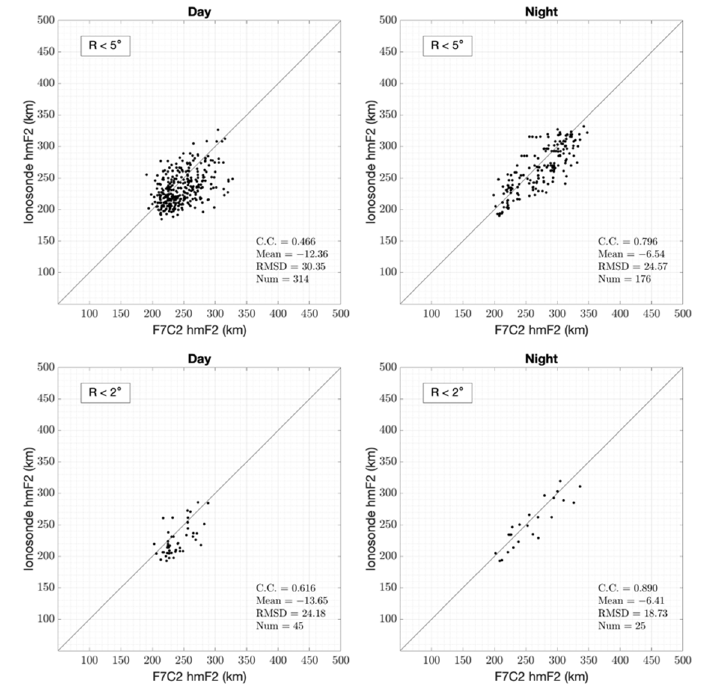
Figure 15. Same as Figure 14, but for hmF2.